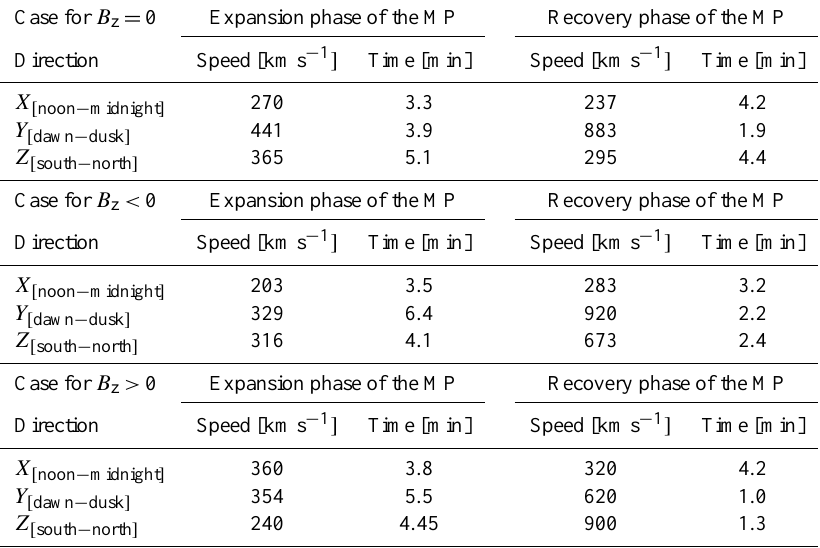
Table 1. Summary of the magnetopause variation in 3-D due to the depression of the solar wind dynamic pressure. The speed and the time relaxation of the expansion and recovery phases is tabulated for B z = 0, B z < 0 and B z > 0, respectively. Case for B z = 0 Expansion phase of the MP Direction Speed [kms − 1 ]